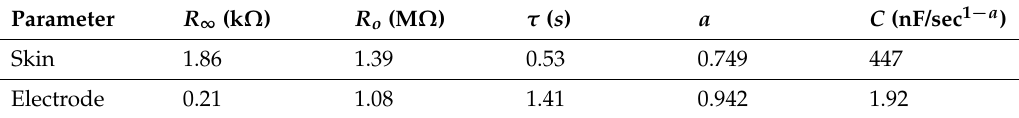
Table 1. Skin (upper arm) and electrode Cole model typical parameter values [16,31].